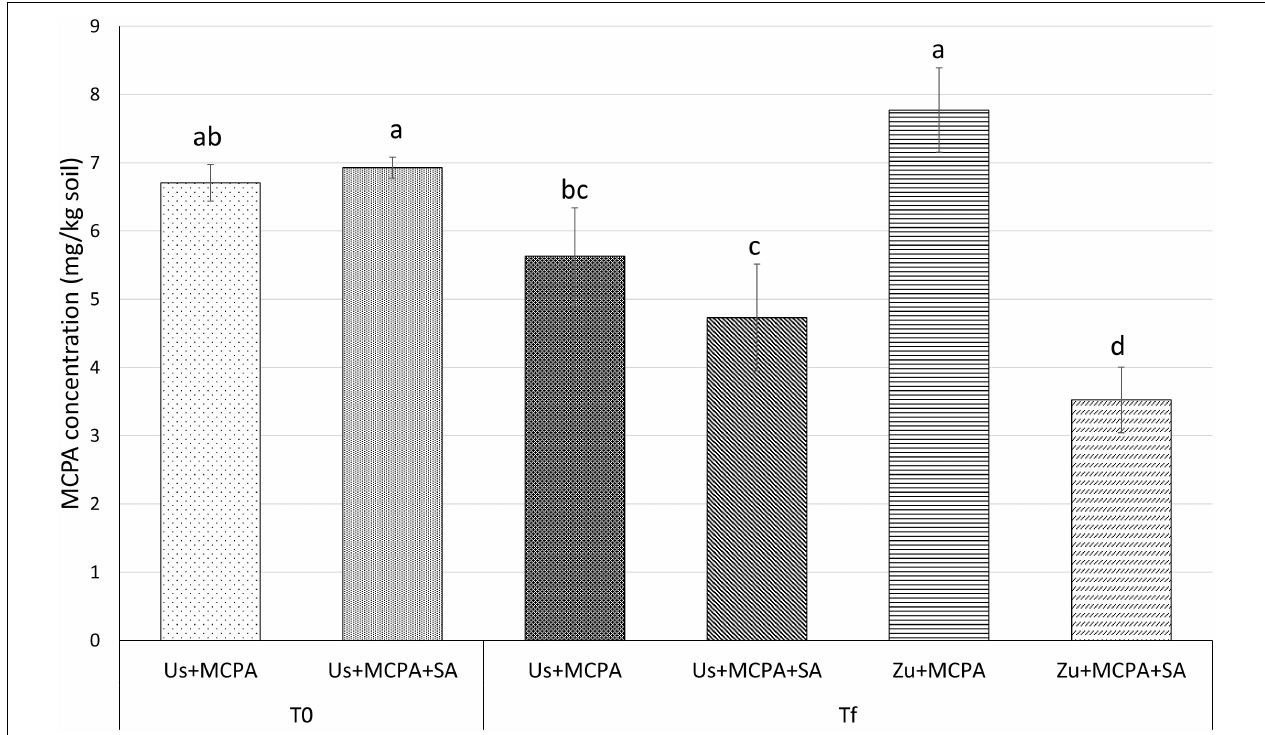
FIGURE 1 | Concentrations of MCPA at the beginning of the experiment (T0) and after 20 days of incubation (Tf) in unplanted soil and in soil after zucchini cultivation. Variants: Us + MCPA, unplanted soil treated with MCPA; Us + MCPA + SA, unplanted soil treated with MCPA and SA; Zu + MCPA, soil after zucchini cultivation treated with MCPA; Zu + MCPA + SA, soil after zucchini cultivation treated with MCPA and SA. Different letters (a-d) indicate significant differences (Tukey’s HSD test, p <